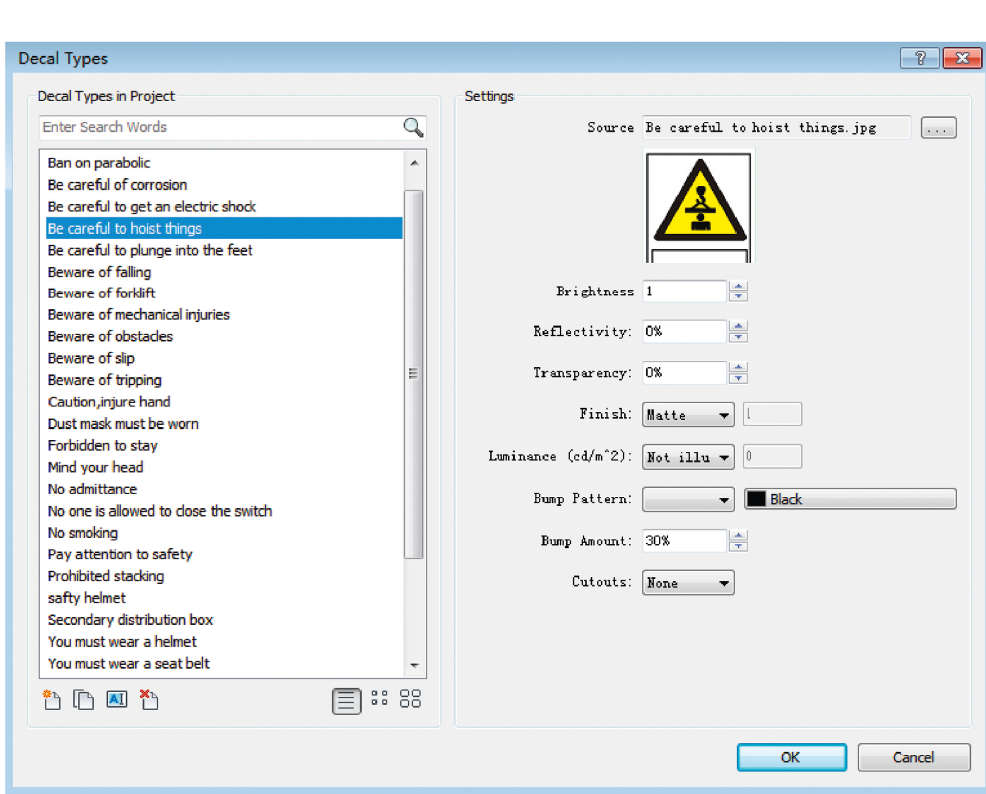
Figure 4: 8# floor